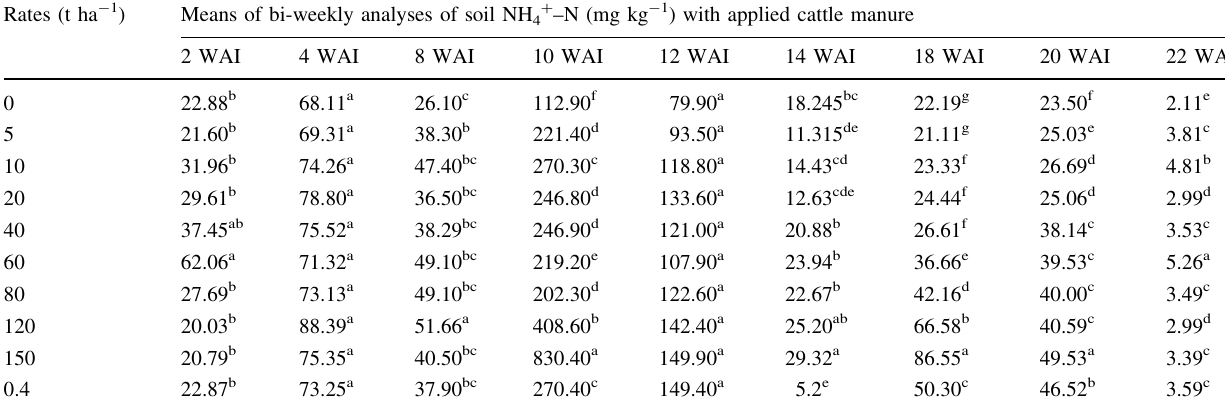
Means followed by the same letter(s) within the same columns do not differ significantly at P \ 0.05 according to Duncan multiple range test